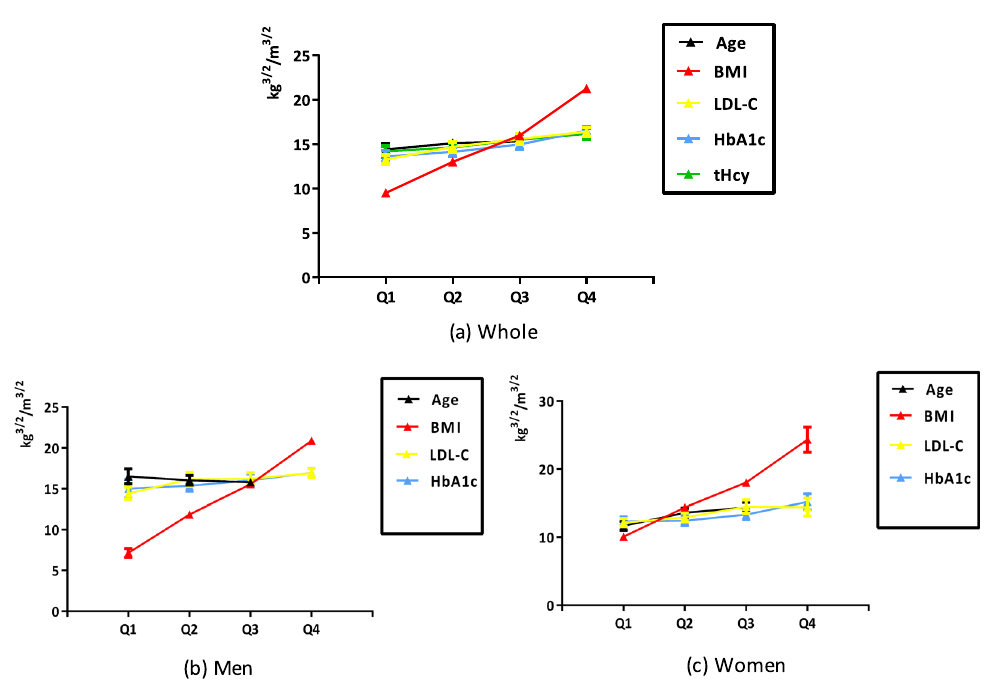
Figure 1. Trends of TBF/CI change in different metabolic risk variables. TBF/CI: total body fat/conicity index; BMI: body mass index; LDL-C: low-density lipoprotein-cholesterol; HbA1c: hemoglobin A1c; tHcy: total homocystein. Age: Quartile1: 20–33 years, Quartile2: 33–38 years, Quartile3: 38–40 years; BMI: Quartile1: < 21.40 kg/m 2 , Quartile2: 21.40–24.20 kg/m 2 , Quartile3: 24.20–27.30 kg/m 2 , Quartile4: > 27.30 kg/m 2